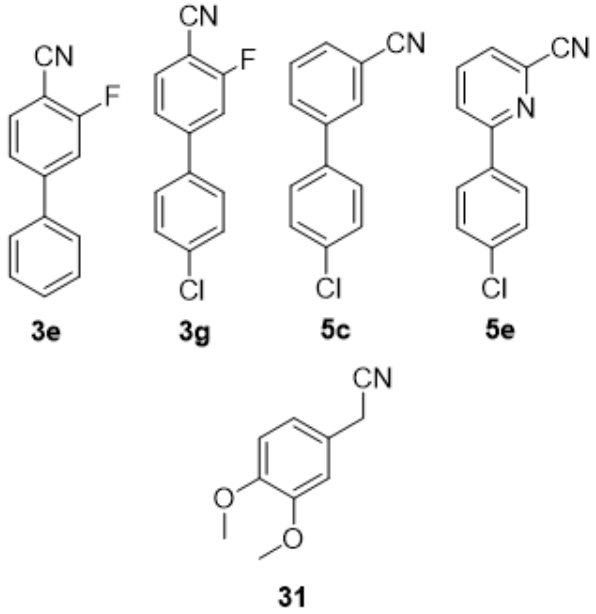
Figure 2. Compounds showing 16% to 50% conversion.